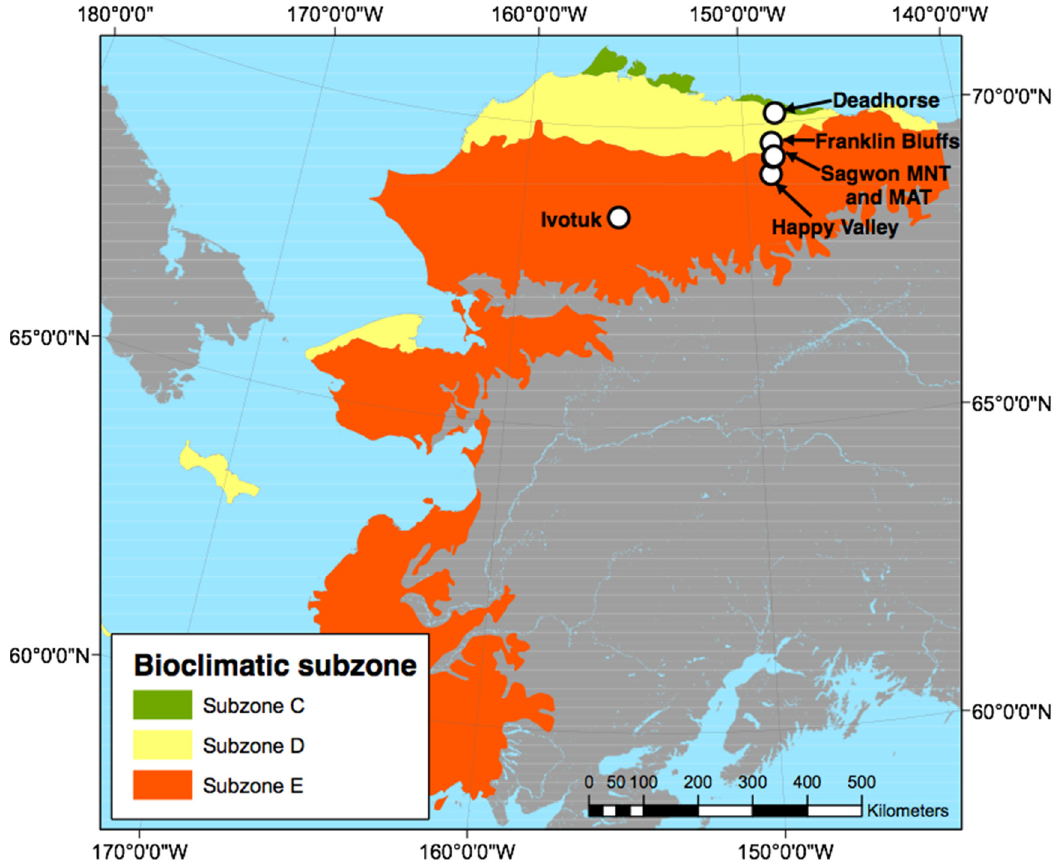
Figure 2. Location of Ivotuk, Deadhorse, Franklin Bluffs, Sagwon-MNT, Sagwon-MAT, and Happy Valley sites on the North Slope of Alaska within the Alaskan bioclimatic subzones of the Circumpolar Arctic Vegetation Map [44].